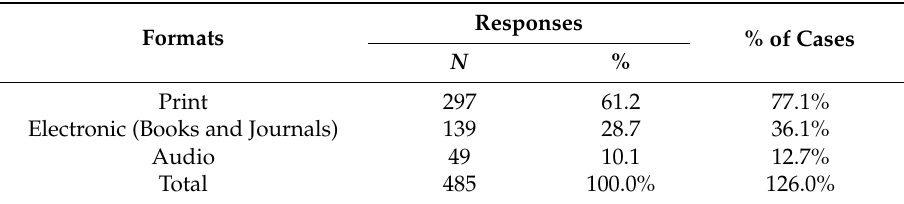
Table 3. Preferred information resource